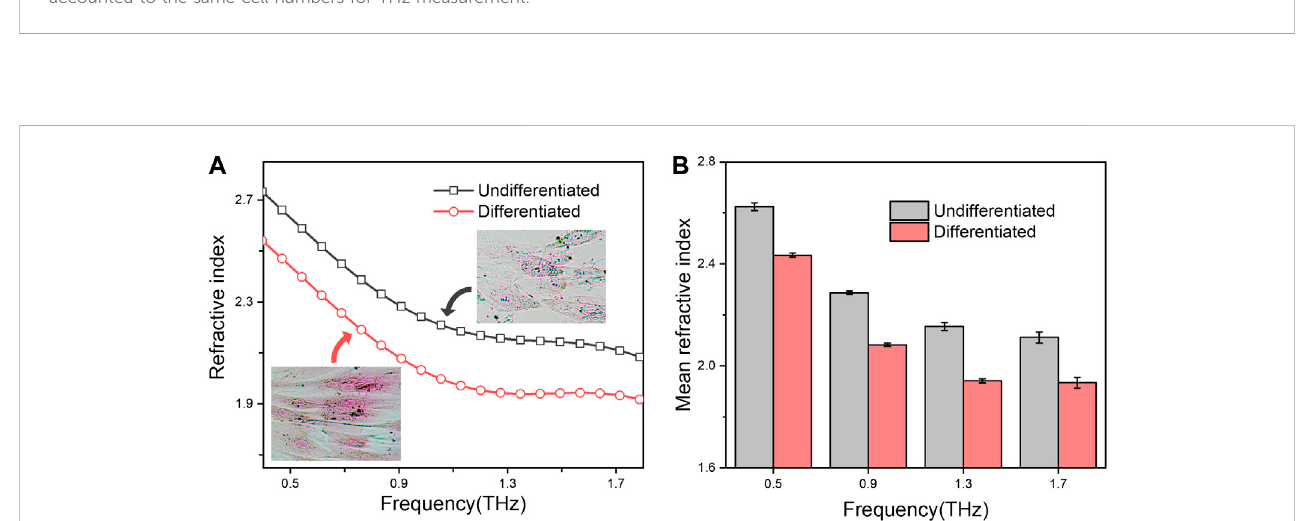
FIGURE 3 (A) Refractive index spectra of undifferentiated or osteogenic differentiated MSCs in droplets. The microscopy photograph of the corresponding cells after alizarin red S staining are shown in insert; (B) Mean refractive index at .5, .9, 1.3 and 1.7 THz. All groups were set to the same cell concentration of 1.0 × 10 5